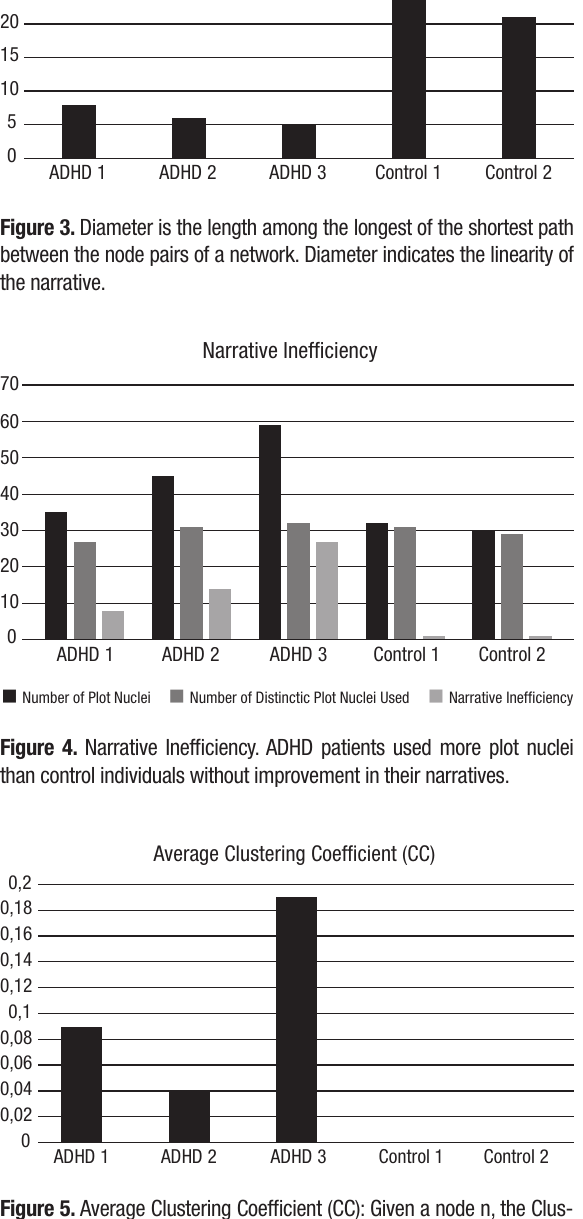
Figure 5. Average Clustering Coefficient (CC): Given a node n, the Clus- tering Coefficient Map (CCMap) is the set of fractions of all n neighbors that are also neighbors of each other. Average CC is the sum of the Clus- tering Coefficients of all nodes in the CCMap divided by number of ele- ments in the CCMap. CC indicates convoluted or disorganized